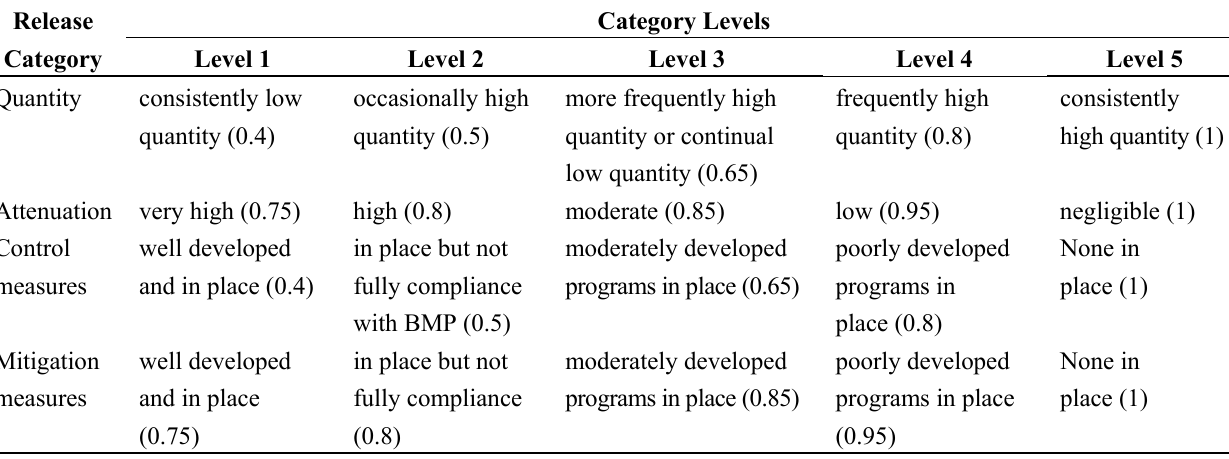
Table 1. Scores for release